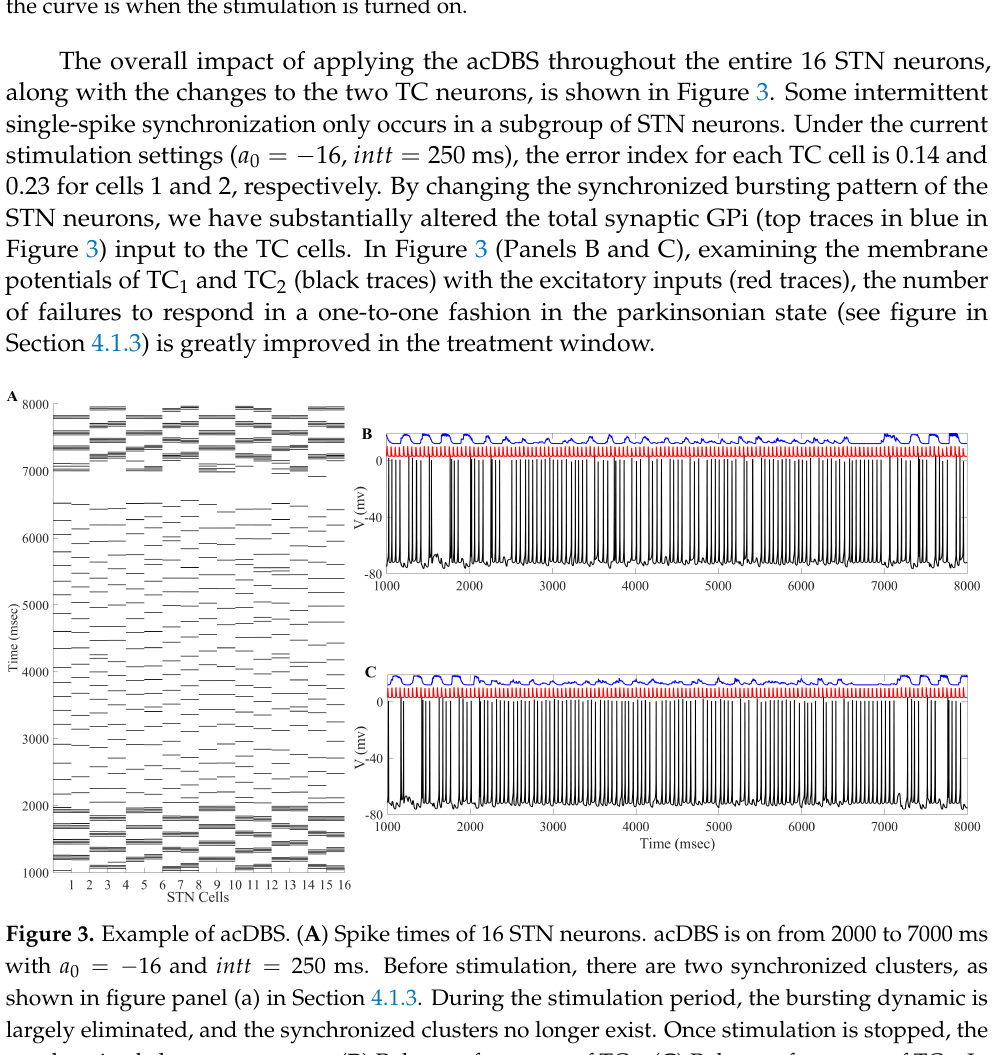
Figure 2. STN 1 membrane potential (black) with corresponding adaptive stimulation received (red) with parameters a 0 = − 16 and interspike time threshold parameter intt = 250 ms. Note that the top part of the red curve represents the time when the stimulation is turned off, while the bottom part of the curve is when the stimulation is turned on.